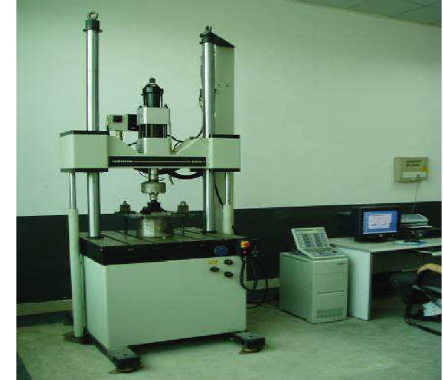
Figure 3: Instron8802 Testing Machine.